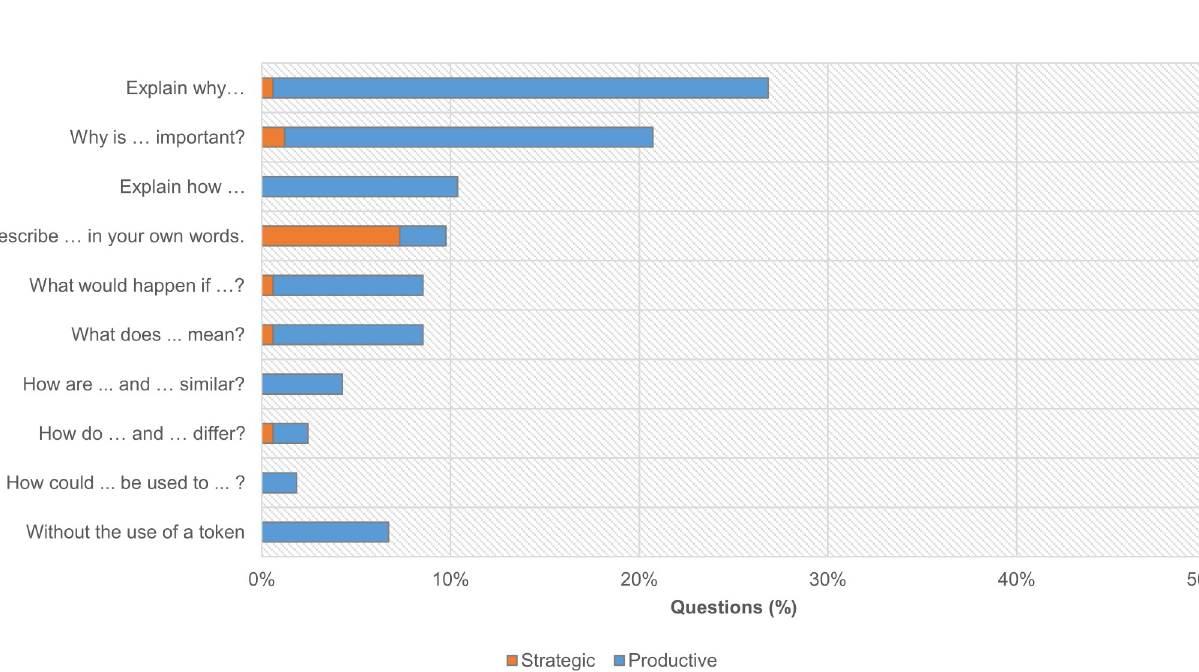
PLOS ONE | https://doi.org/10.1371/journal.pone.0262853 February 10, 2022 19 /